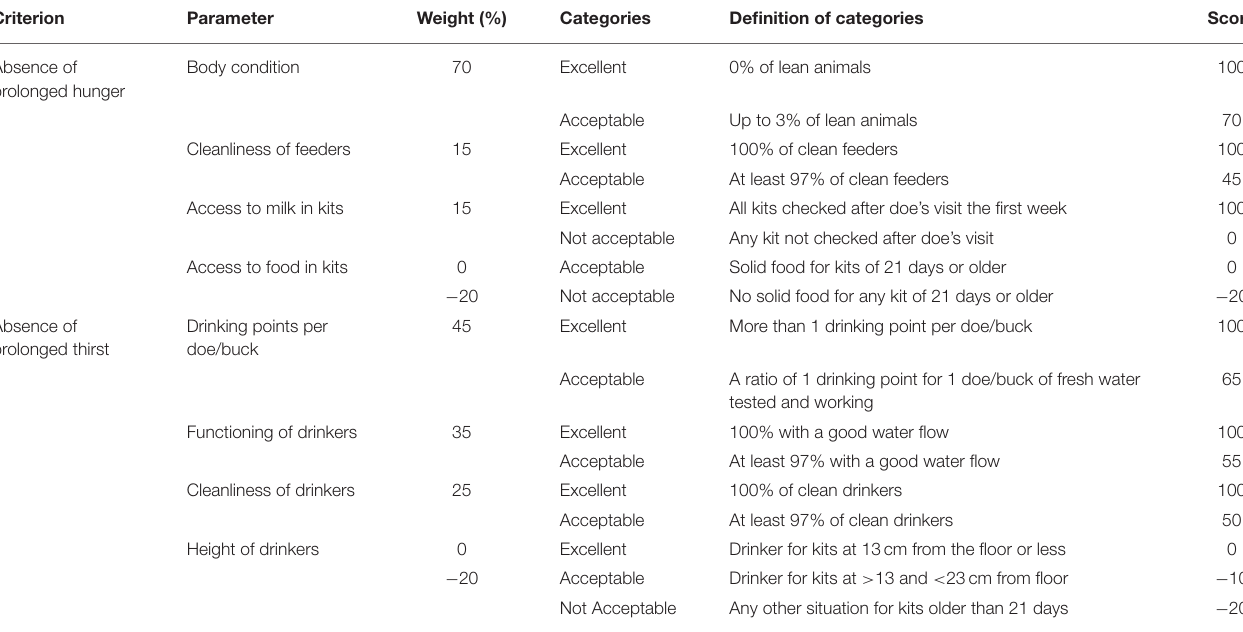
TABLE 2 | Parameters used to assess the criteria of absence of prolonged hunger and absence of prolonged thirst.